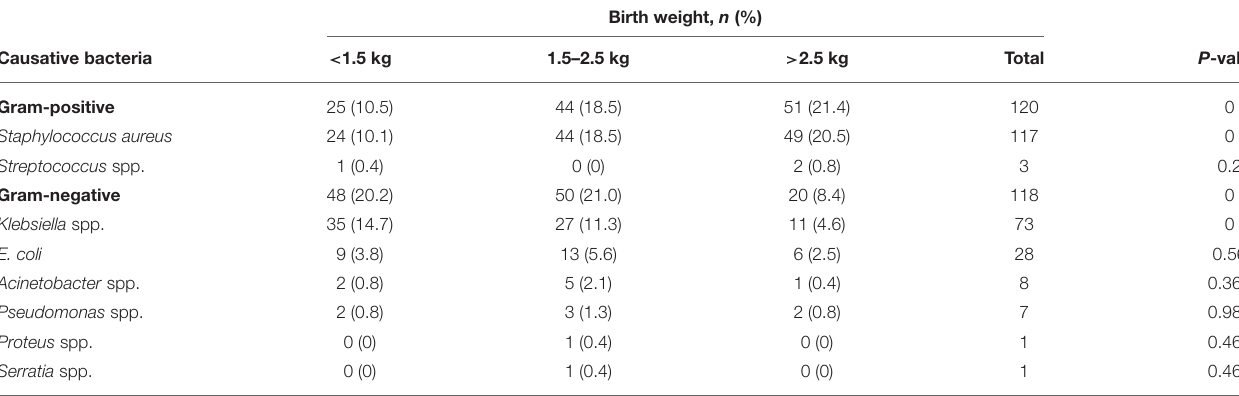
TABLE 5 | Distribution of microorganisms according to birth weight classification.